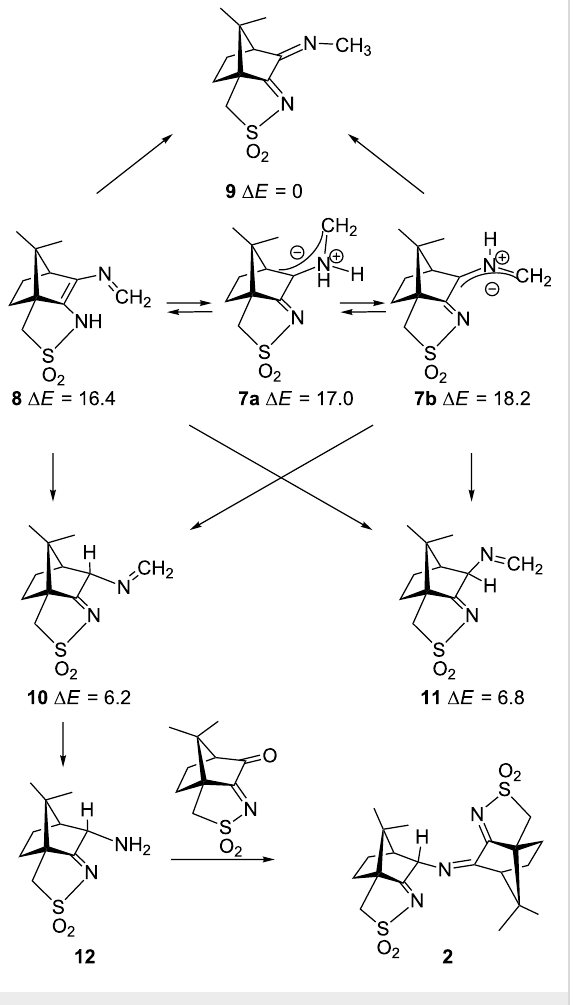
Table 1: Calculated activation energies ∆ E a (kcal/mol) for the water- catalyzed isomerization of 7 – 11 a . Compound